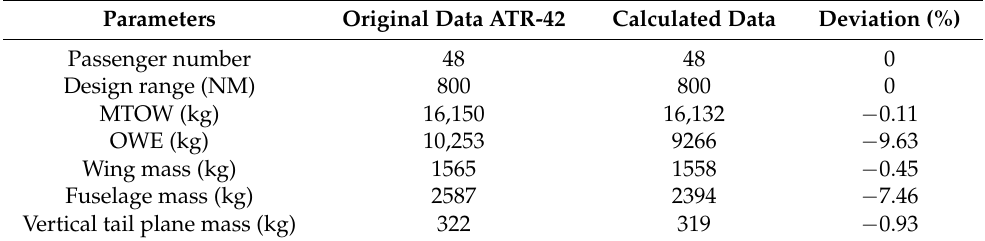
Table 2. Simulation tool validation: Comparison of the simulated ATR-42 data with reference